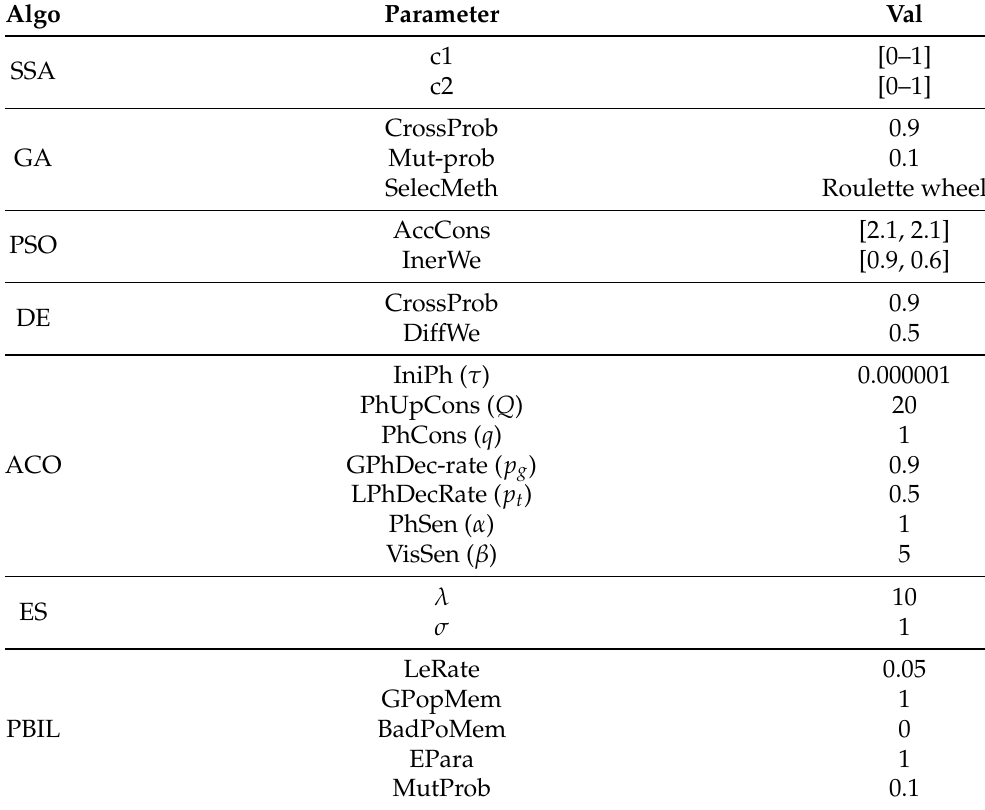
Table 3. The parameters’ values for the applied